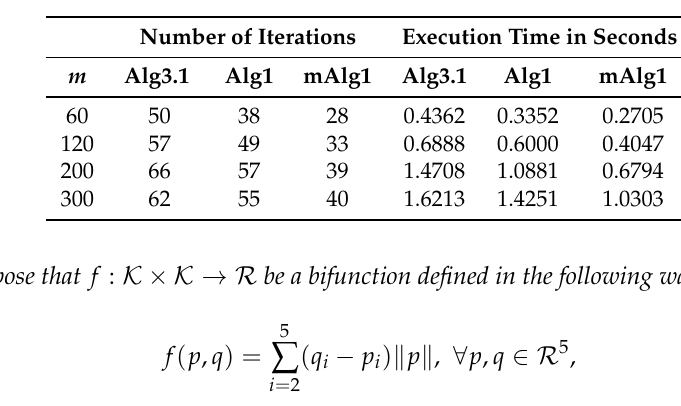
Figure 8. Example 1: Algorithm 1 (mAlg1) numerical comparison with Algorithm 3.1 (Alg3.1) in [39] and Algorithm 1 (Alg1) in [38] while m = 300.